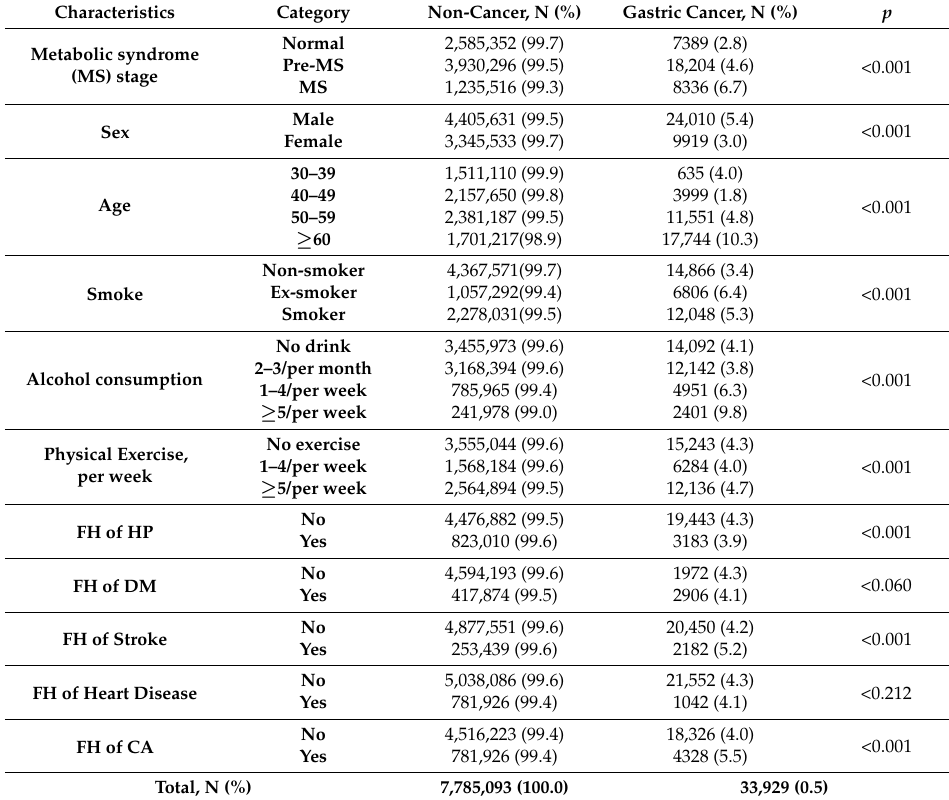
Table 2. Incidence rate of gastric cancer by